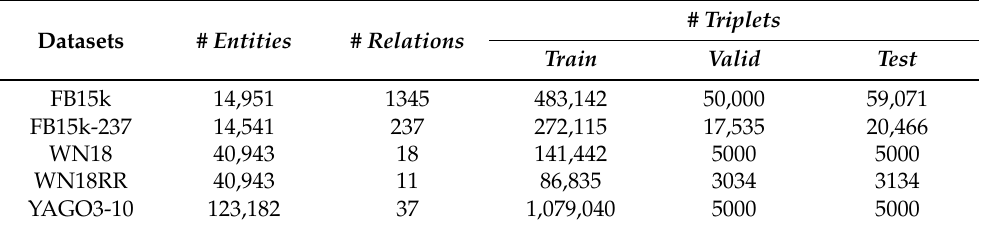
Table 1. Real-world KB